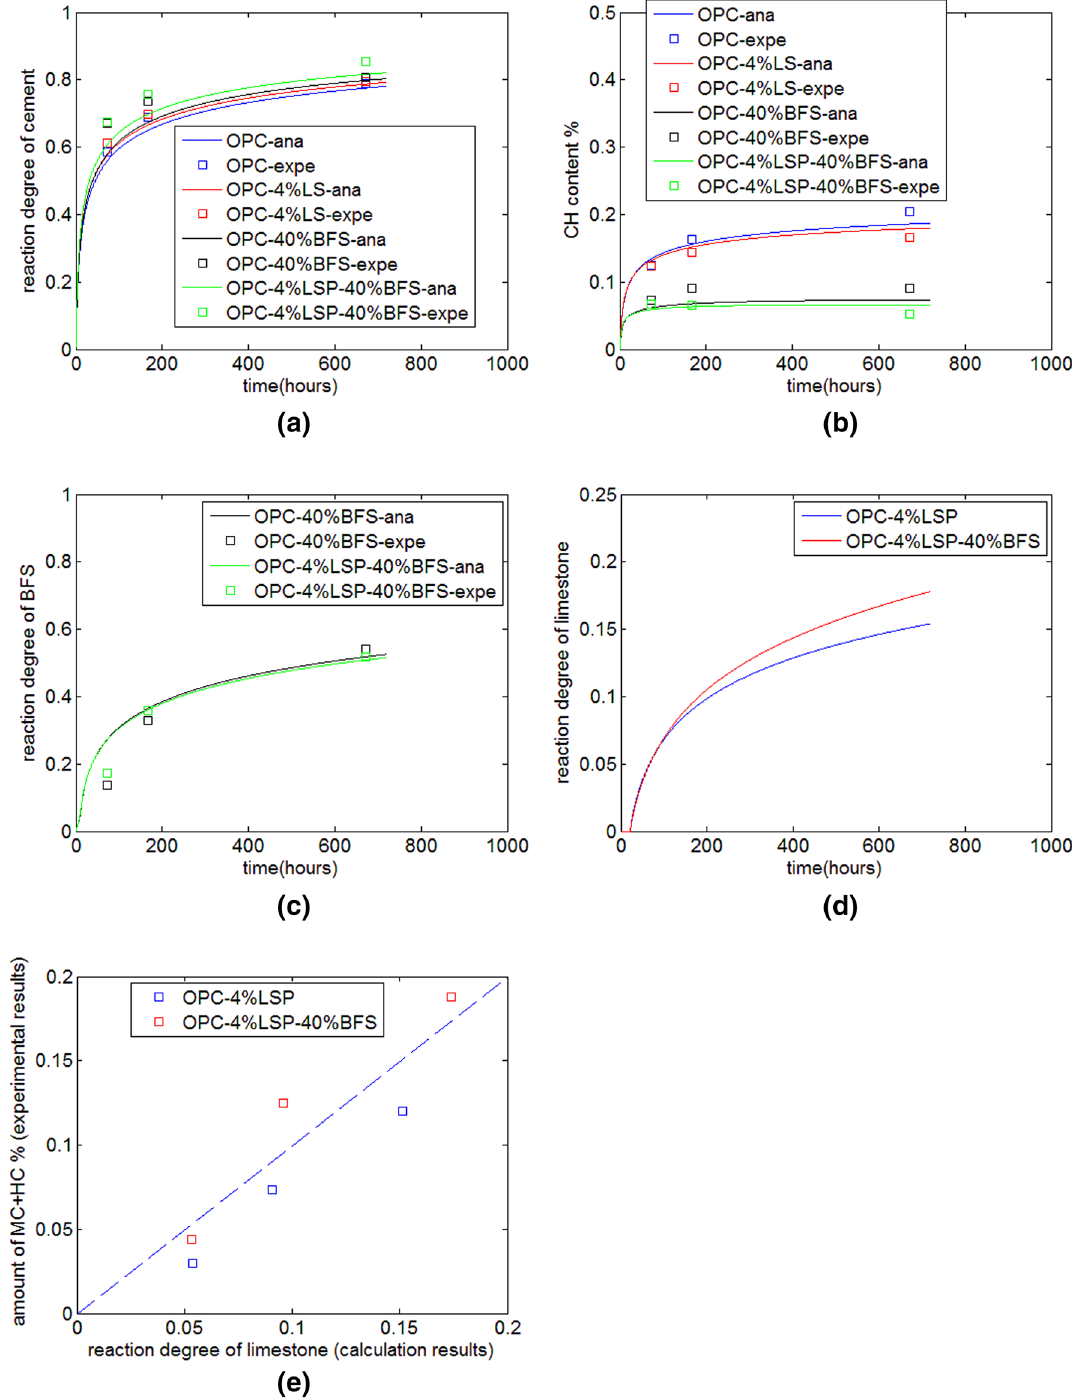
Fig. 5 Properties evaluation of cement-slag-limestone ternary blends. a reaction degree of cement, b calcium hydroxide content, c reaction degree of slag, d reaction degree of limestone, e relation between reaction degree of limestone and monocarbonate plus